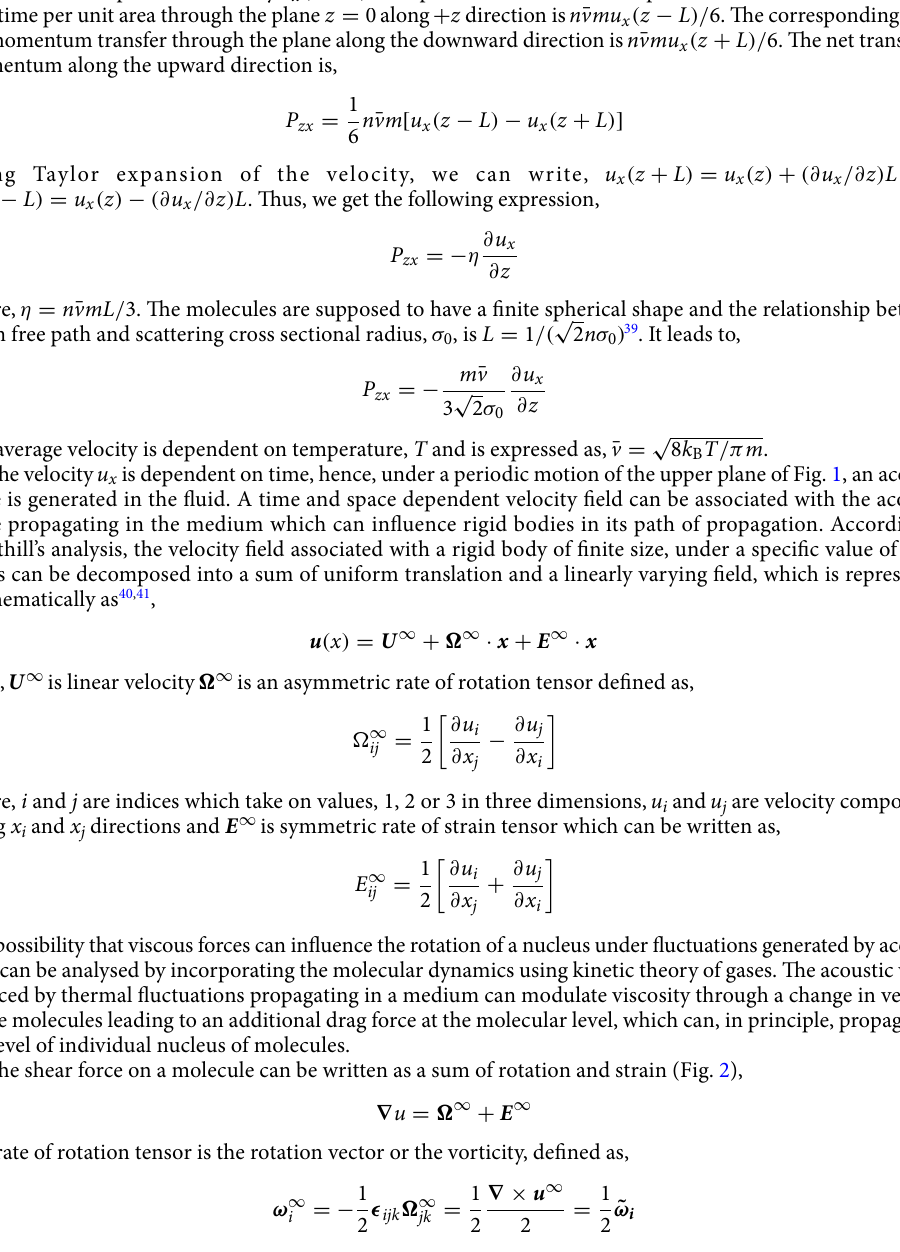
x direction. The velocity components are dependent on the coordinate x and − +